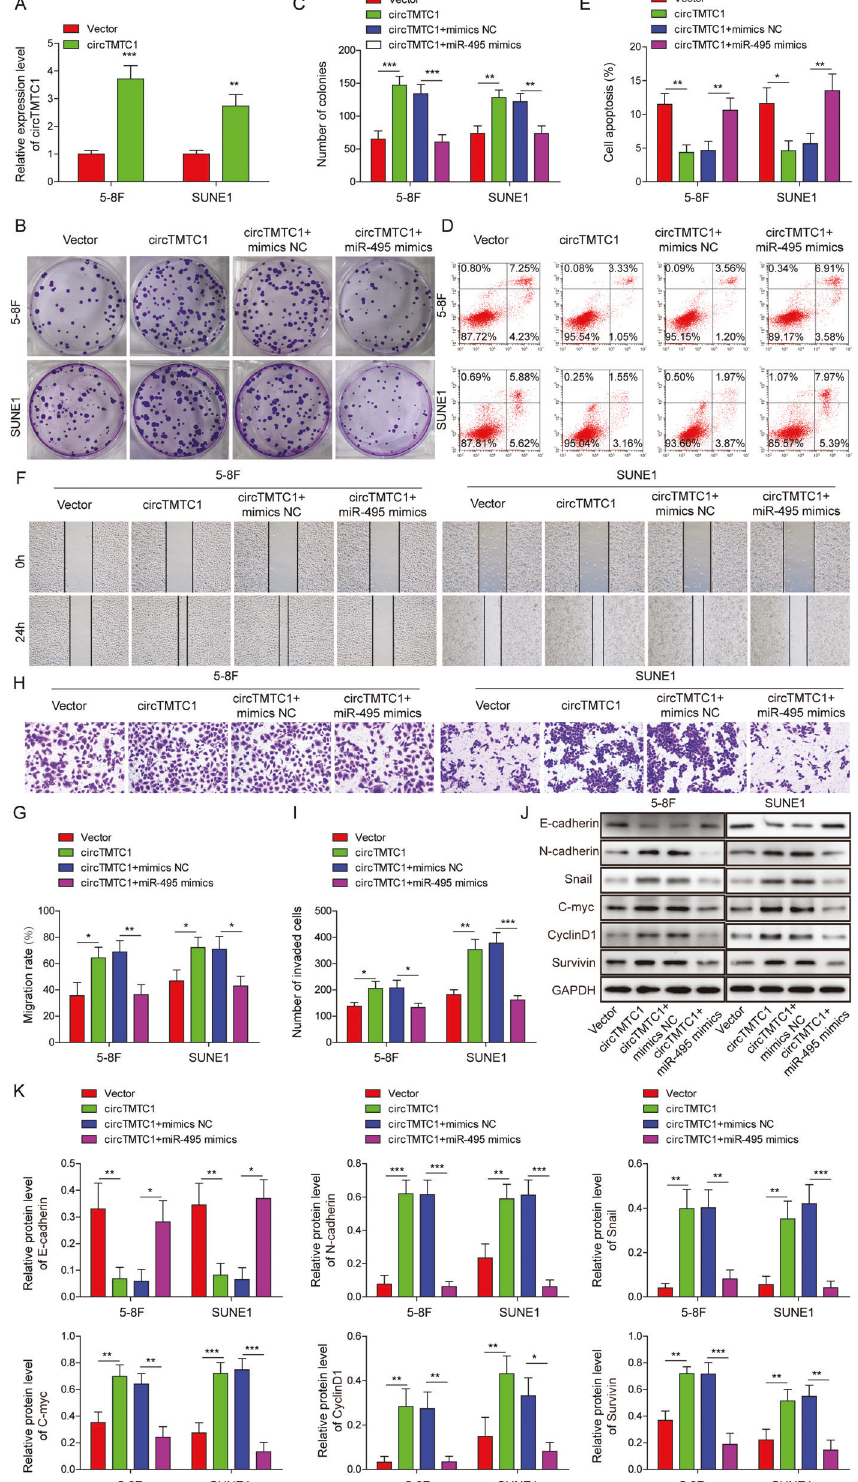
Fig. 4 CircTMTC1 promoted NPC cell malignant phenotypes and enhanced cell apoptosis by directly targeting miR-495. NPC cells were transfected with vector control, circTMTC1, circTMTC1 + mimics NC or circTMTC1 + miR-495 mimics respectively. A The relative expression of circTMTC1. Data from three independent experiments was normalized to GAPDH. B , C Colony formation analysis of NPC cells. D , E Cell apoptosis analysis by fl ow cytometry. Scratch wound healing ( F , G ) and transwell invasion ( H , I ) analysis for NPC cells. J , K The expression of E/ N-cadherin, Snail, c-Myc, Cyclin D1 and Survivin. * P < 0.05, ** P < 0.01 and *** P < 0.001.